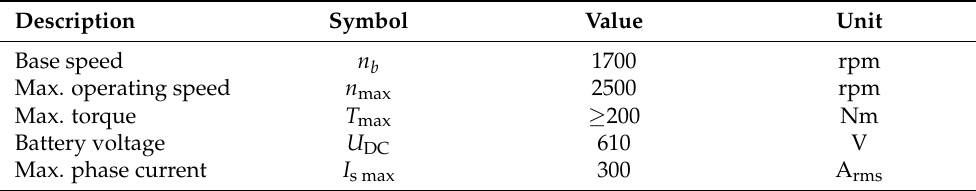
Table 1. Peak operation requirements at base